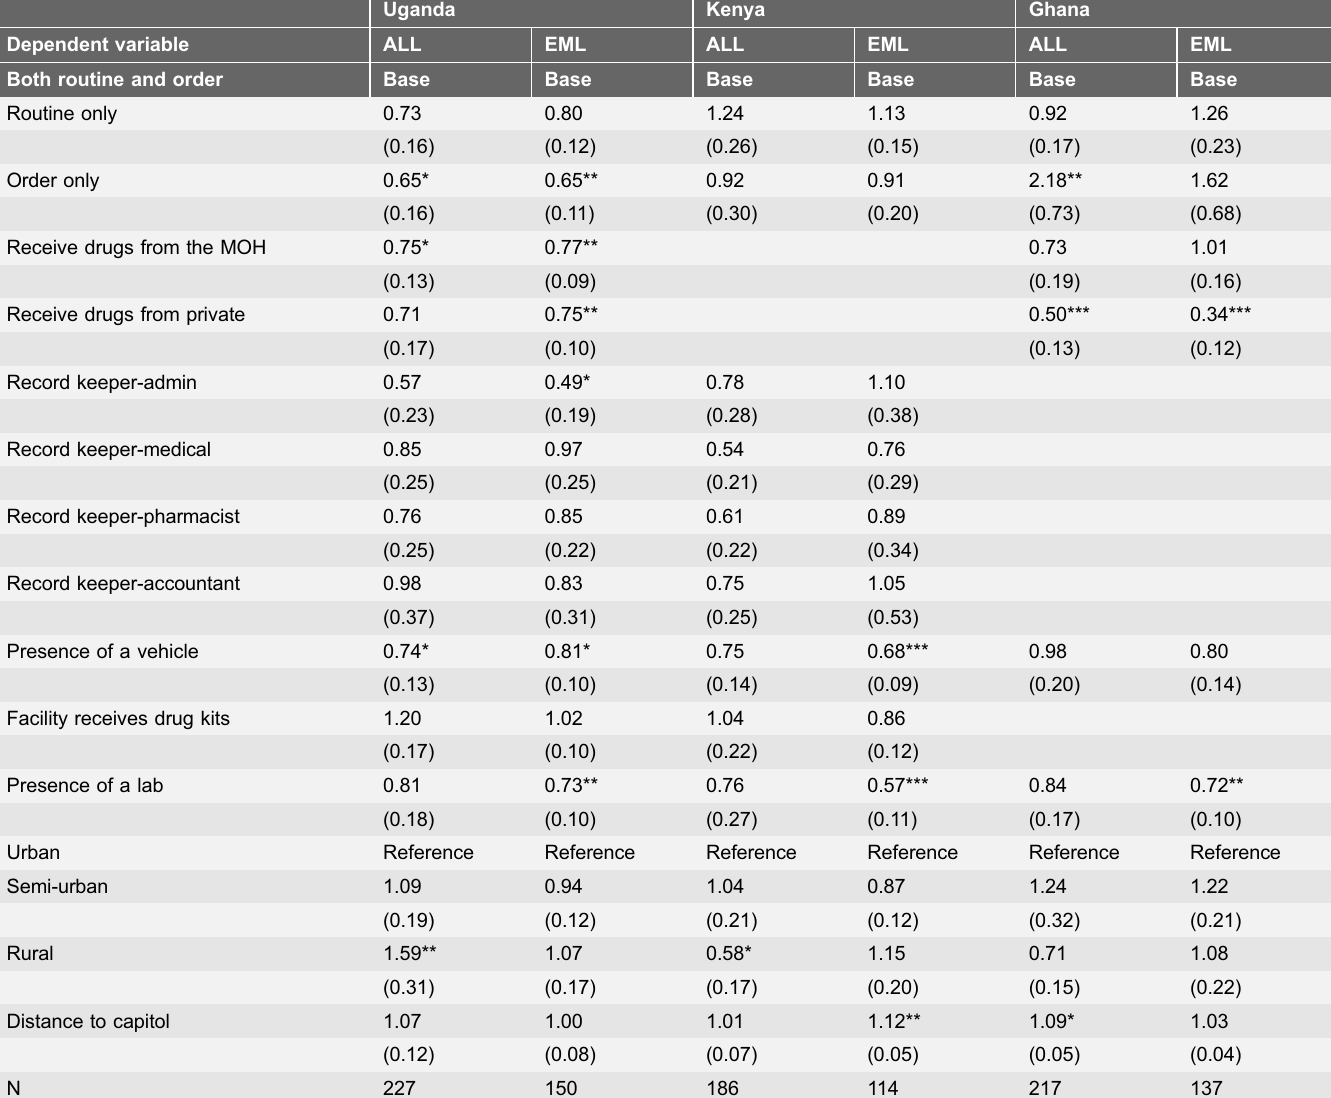
Table 4. Generalized linear model results of pharmaceutical stock-out in Uganda, Kenya and Ghana.